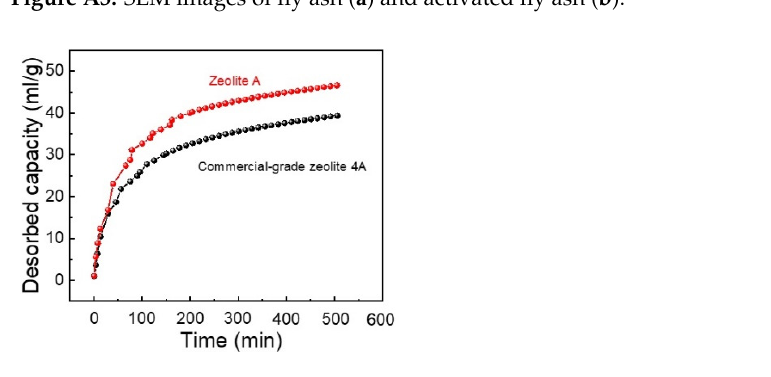
Figure A4. The relationship between carbon dioxide adsorption capacity and time.